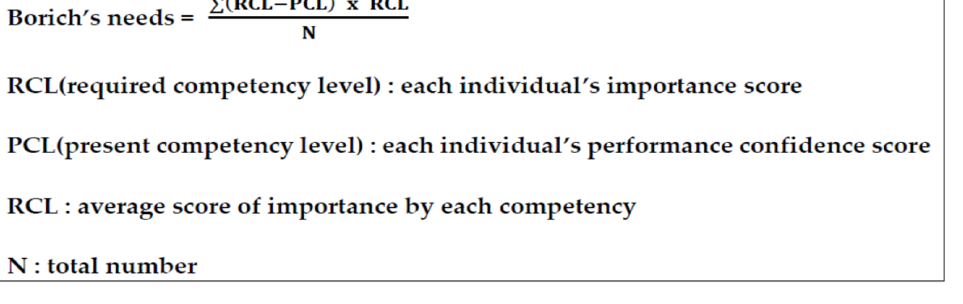
Figure 1. The formula for the priority decision of Borich.